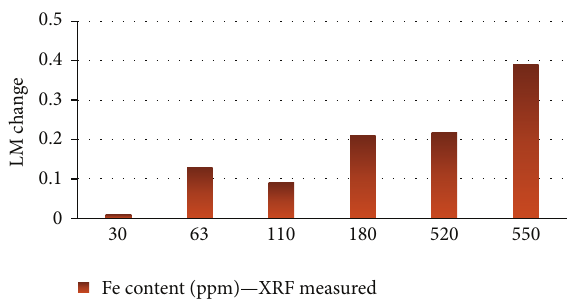
Figure 9: Correlations between LM and Fe content